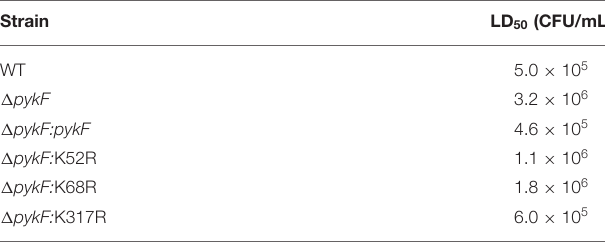
TABLE 4 | Comparison of LD 50 between WT, 1 pykF , and all complemented strains.